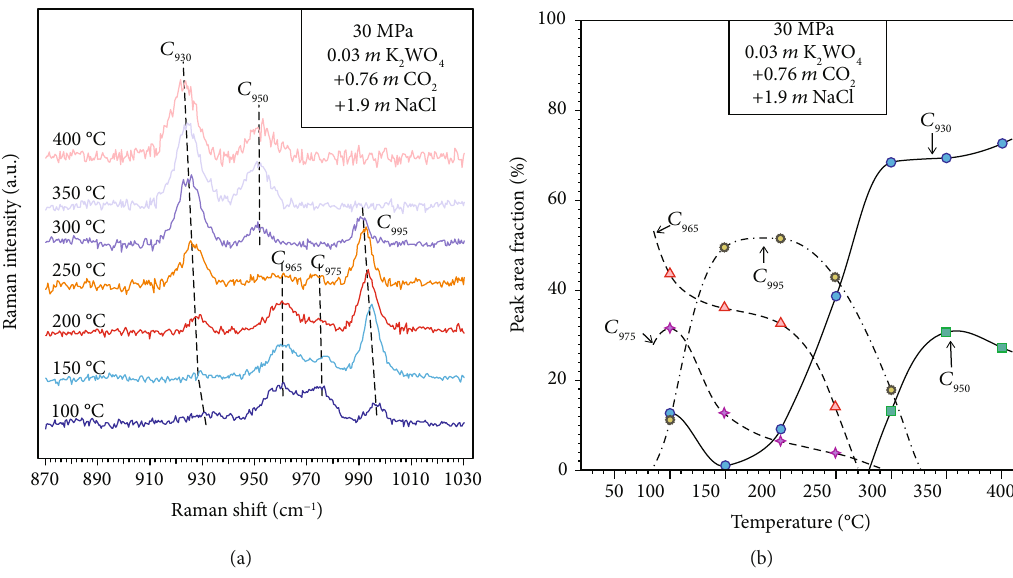
Figure 5: (a) In situ Raman spectra of 0.03 m K di ff erent v 1 (W=O) bands as a function of temperature for the solution shown in (a). It should be noted that the lines in the fi gure are used to show the general variation trend of the peak area fractions. Data plotted are those listed in Table